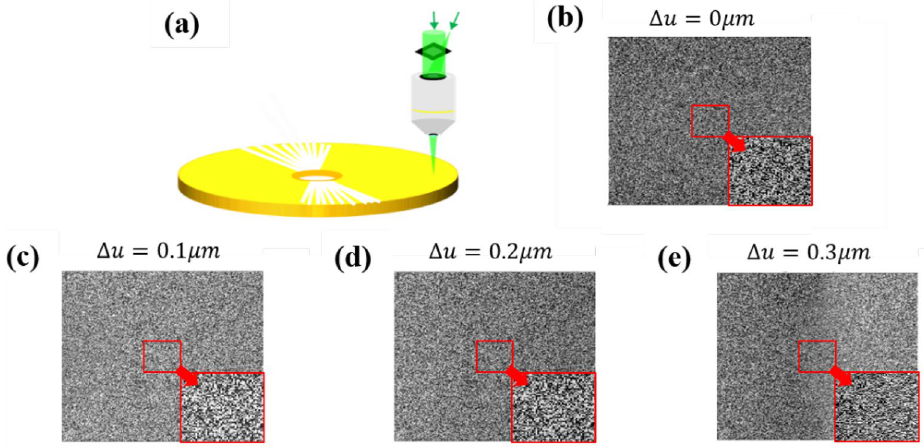
Figure 3. Simulations of the readout signal with phase encoding. (a) The schematic diagram of the pickup head, and the readout signal when the disc is displaced for (b) 0 μm, (c) 0.1 μm, (d) 0.2 μm, (e) 0.3 μm.